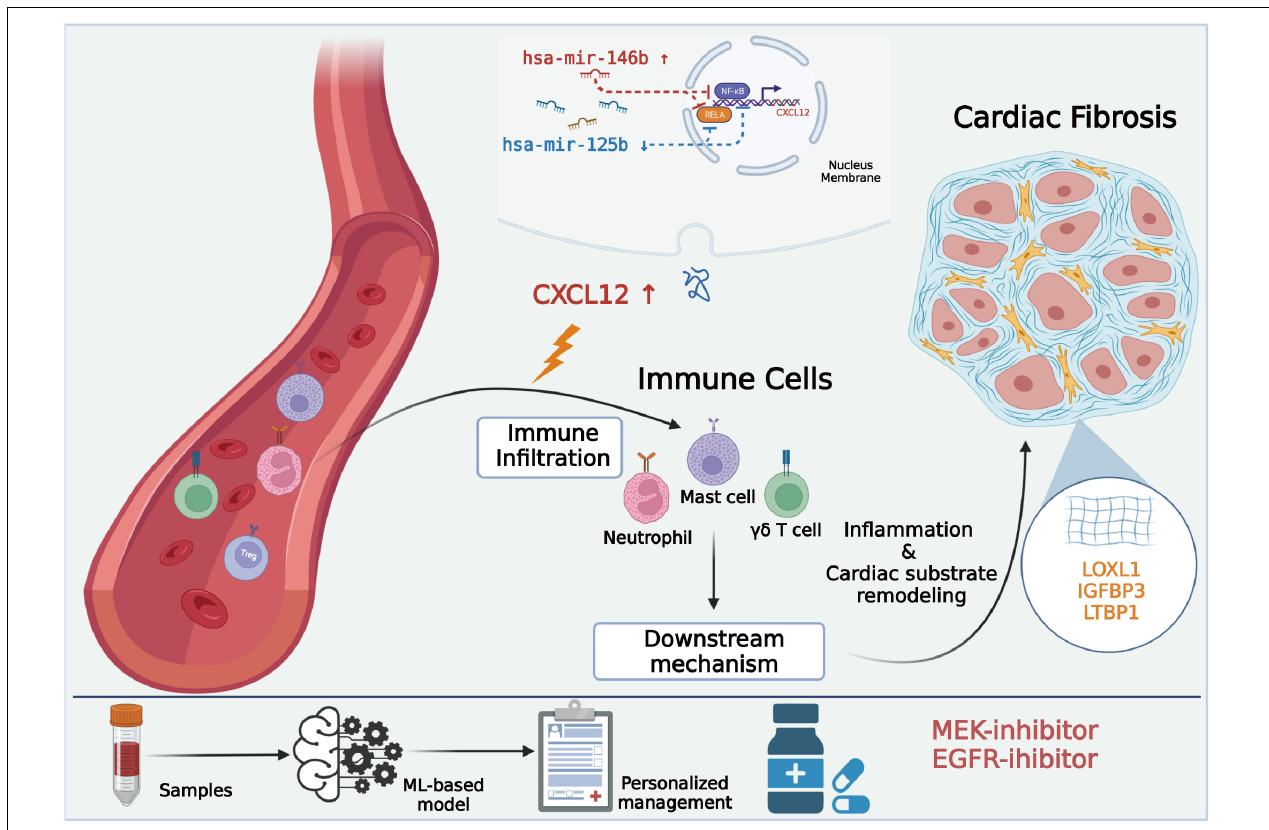
FIGURE 11 | Central illustration of the key findings. CXCL12 may play as an upstream mediator and its TF-miRNA-mRNA regulation network was shown in the graph. LOXL1, IGFBP3, LTBP1 may impose important effect on atrial fibrosis, which was the pathogenetic cornerstone of AF. The ML-based model could be used in personalized diagnosis and management. MEK inhibitor and EGFR inhibitor may be potential non-channel drugs for atrial fibrillation. AF, atrial fibrillation. ML, machine learning. MEK, mitogen-activated protein kinase. EGFR, epidermal growth factor receptor (Created with